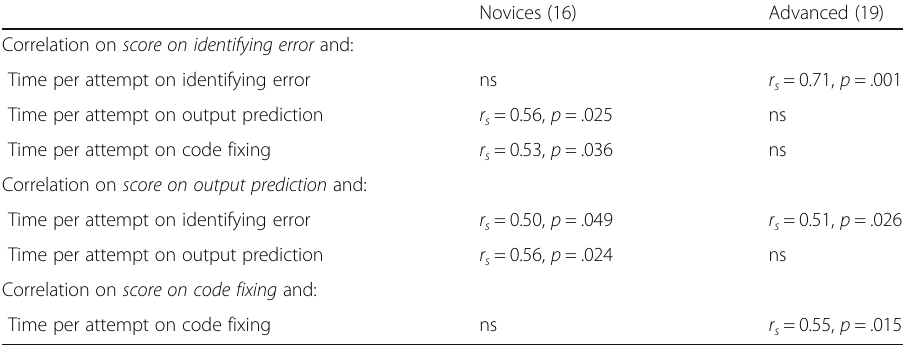
Table 8 Spearman ’ s correlations between score and time per attempt ( ns denotes not significant) Novices (16) Advanced